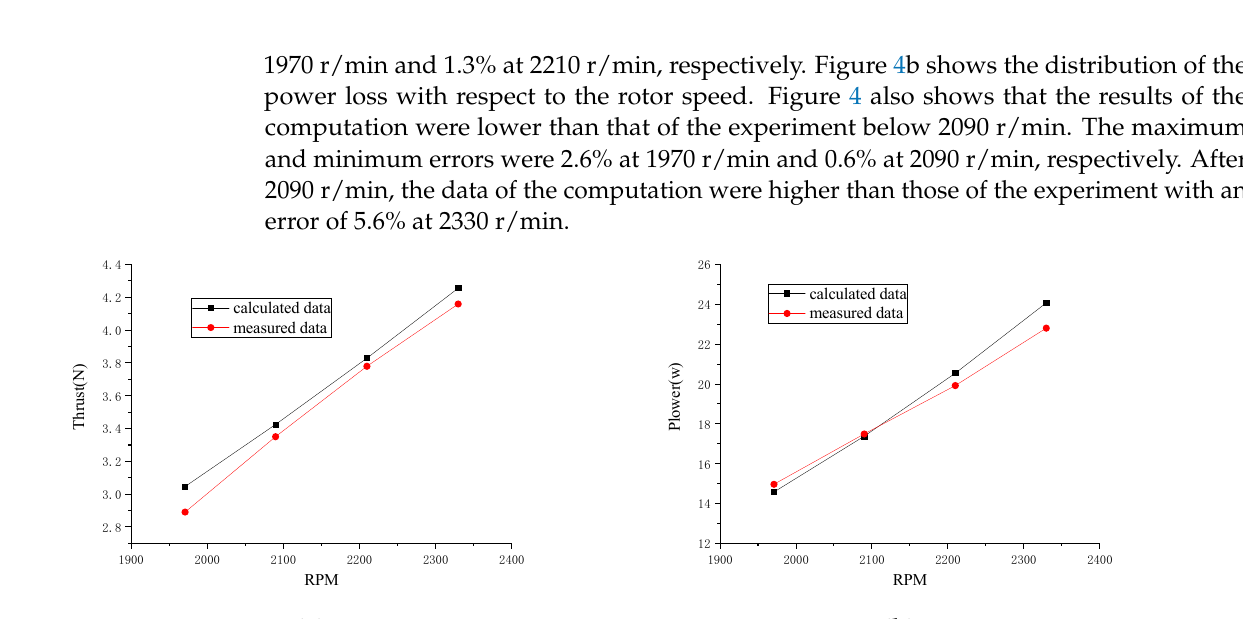
( c ) Figure 6. Pressure coefficient distribution line of presented airfoil surface at Re 70,000. ( a ) α = 4°; ( b ) α = 8°; ( c ) α = 12°. Figure 7 shows the thrust distribution at 1970 r/min, 2090 r/min, 2210 r/min and 2330 r/min. It can be seen that the thrust increased linearly as the position was less than 0.6 R and reached a maximum at 0.75 R.